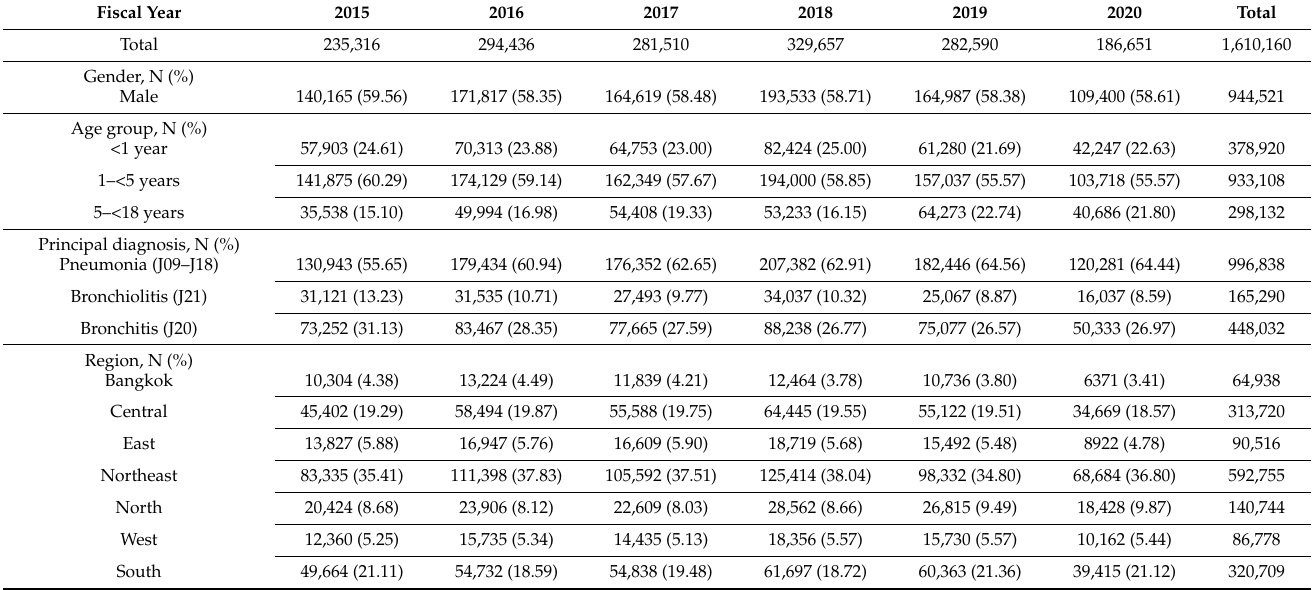
Table 1. The proportion of LRTIs in hospitalized children during the fiscal years